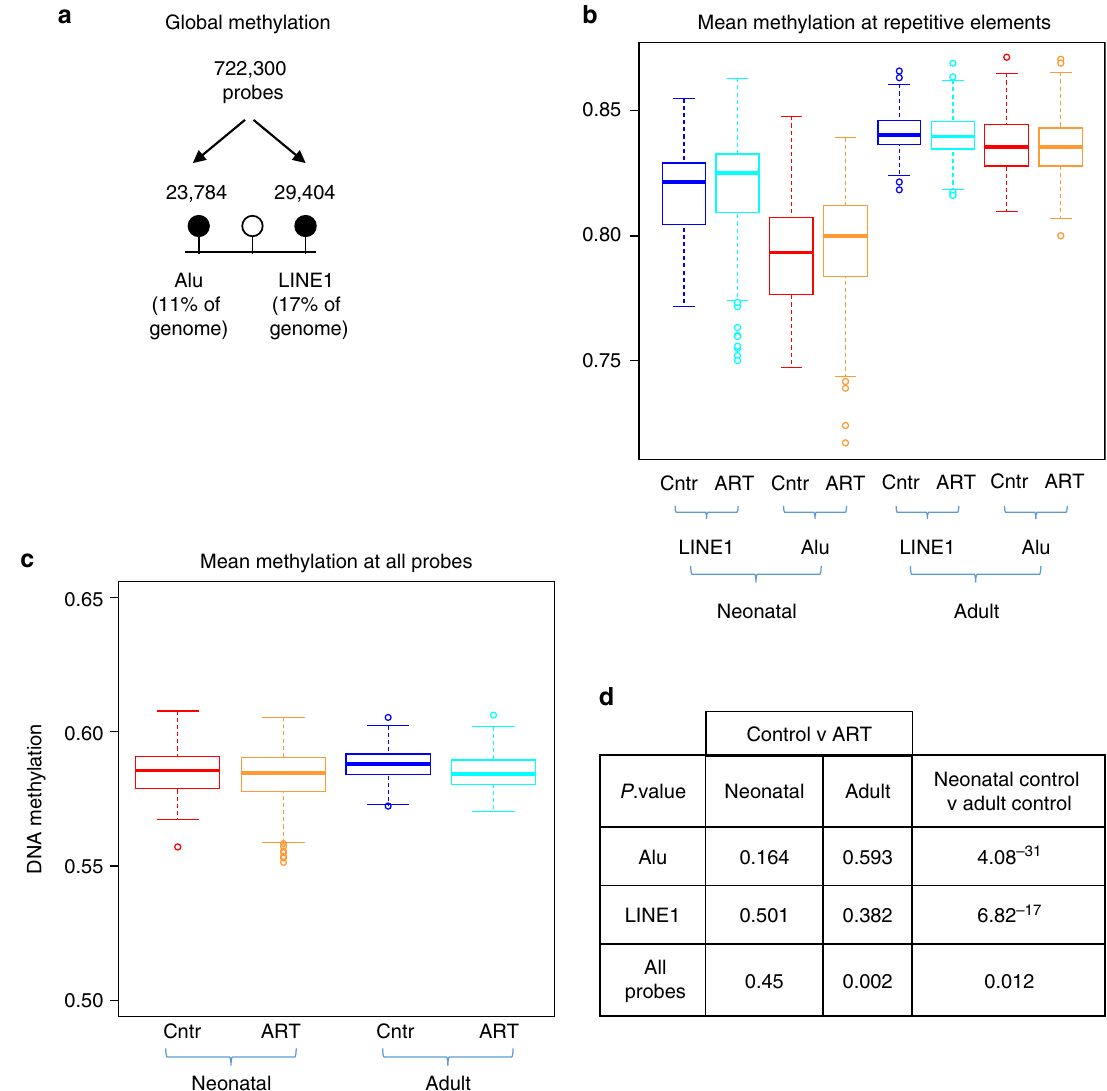
Fig. 6 No evidence for ART-associated DNA methylation change at repetitive elements. a Global DNA methylation was assessed by grouping EPIC probes into Alu or LINE1 repetitive element regions using the REMP tool. b Boxplot of mean DNA methylation level of all probes at Alu and LINE1 in neonatal and adult blood. An age-effect is observed, but no signi fi cant differences between control and ART groups are detected. Boxplot elements are: center line- median; box limits-upper (Q3) and lower (Q1) quartiles; whiskers – smallest and largest non-outlier; points-outliers. c . Mean DNA methylation across